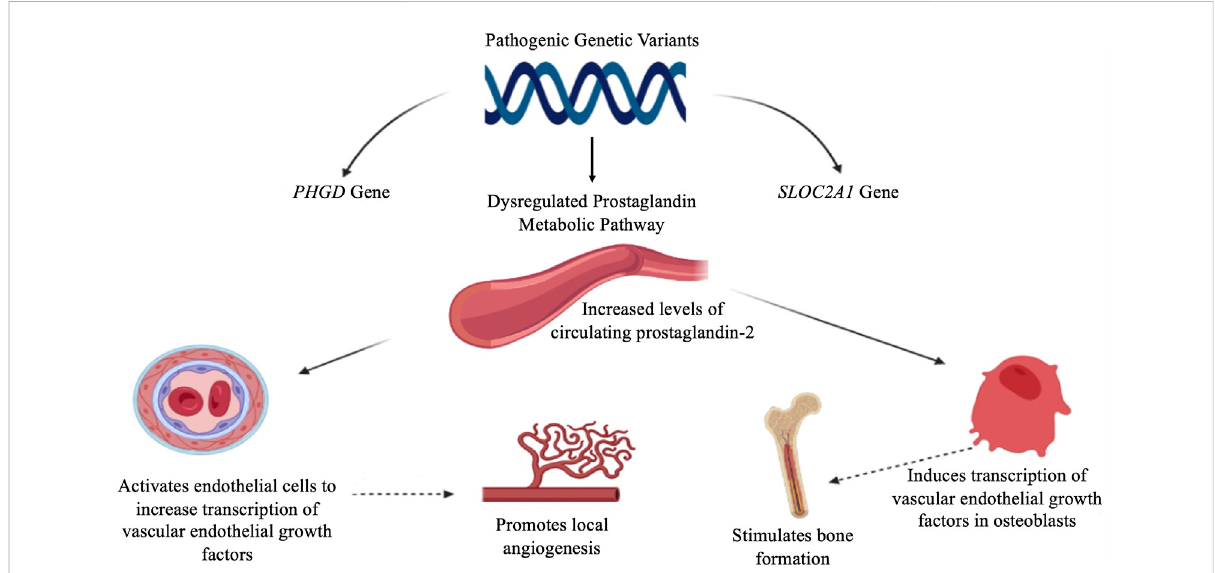
FIGURE 3 Proposed pathophysiology of primary hypertrophic osteoarthropathy. PGE2 inducesthe transcriptionof VEGFin osteoblasts and promotionof endothelial cells, leading to local angiogenesis and a new bone formation. PGE2: prostaglandin E2, VEGF: vascular endothelial growth